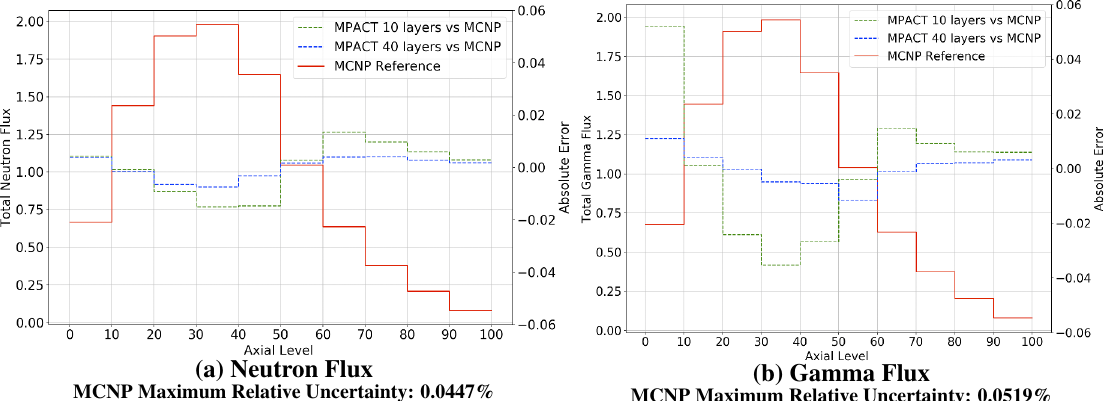
Figure 4: 5 × 5 Assembly Axial Flux Distribution (Control Rod Half Inserted)